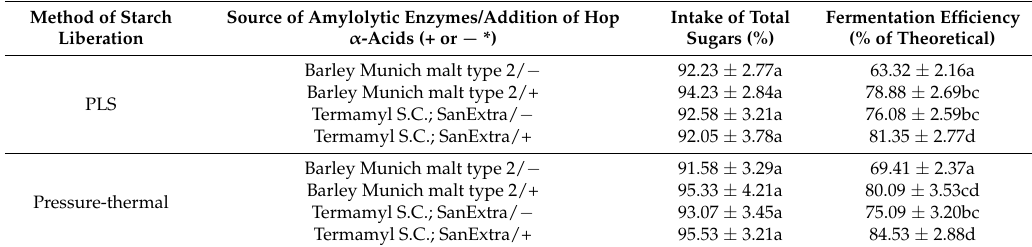
Table 5. Ethanol fermentation